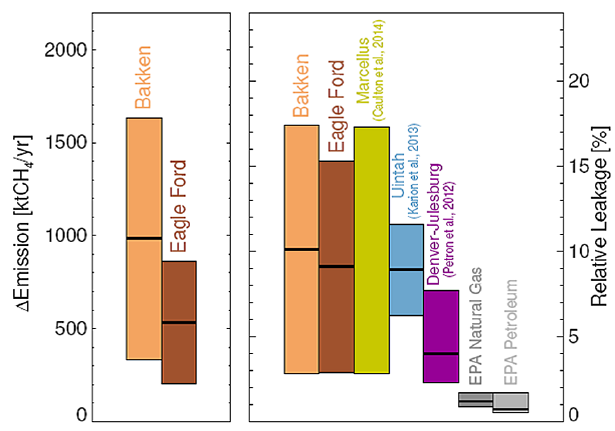
Figure 38. Estimated methane emissions are shown for the tar- geted regions Bakken in light brown, and Eagle Ford in dark brown from satellite remote sensing measurements (Schneising et al., 2014). Shown are absolute emission increases (2009–2011 rel- ative to 2006–2008) in the left panel, and the leakage rates relative to production in the right panel, with the 1 σ uncertainty ranges. For comparison, leakage estimates from previous studies in Marcellus (2012) (Caulton et al., 2014), Uintah (2012) (Karion et al., 2013), Denver–Julesburg (2008) (Pétron et al., 2012). EPA bottom-up in- ventory estimates for natural gas and petroleum systems (2011) are shown for comparison (EPA,